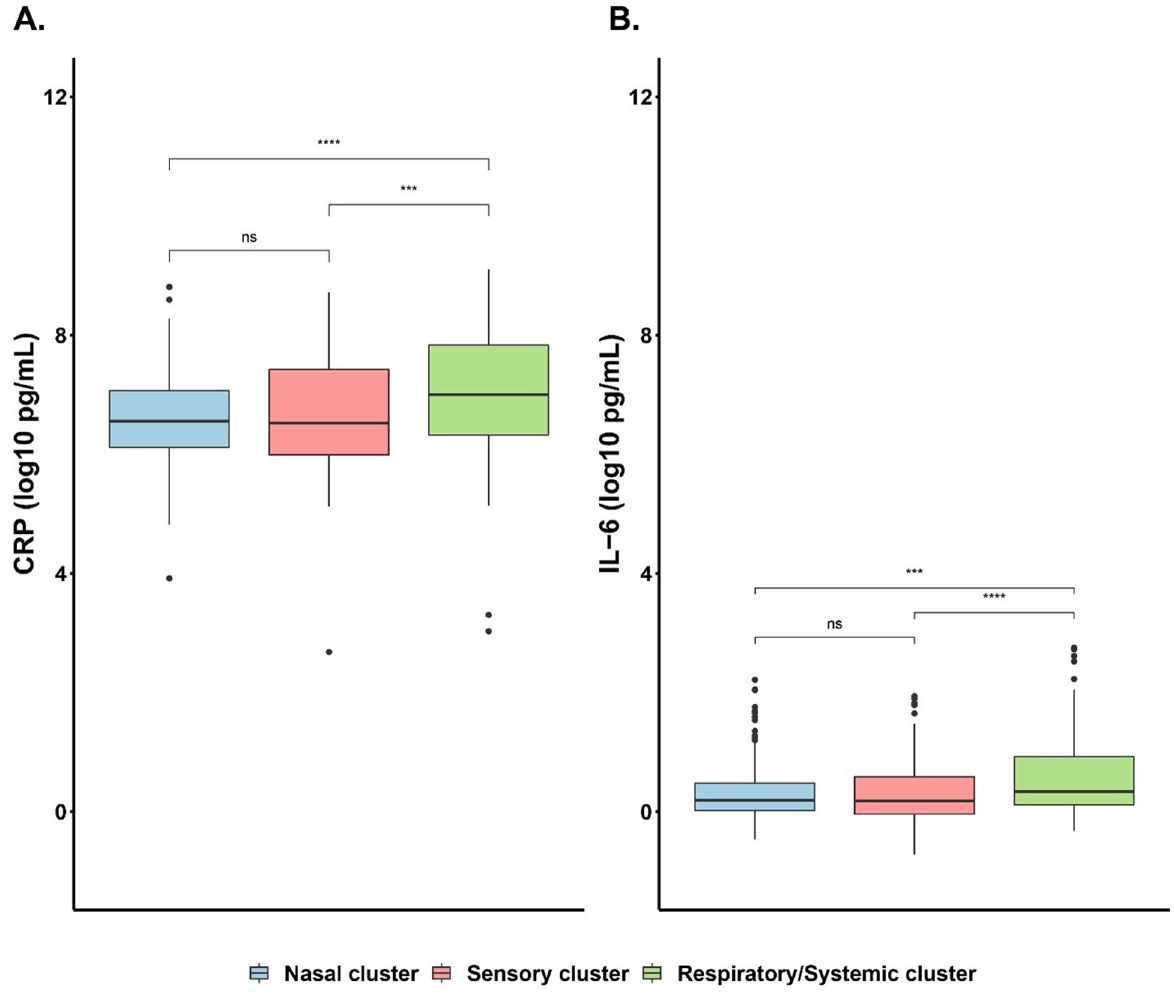
Fig 3. Comparison of inflammatory biomarker (A) CRP and (B) IL-6 in identified clusters. Statistical significance was determined by Wilcoxon rank sum test. Asterisks indicate statistical significance: ns: p > 0.05, � : p � 0.05, �� : p � 0.01, ��� : p � 0.001, ���� : p � 0.0001.